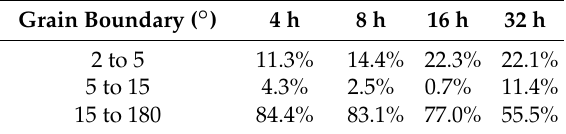
Table 4. Grain boundary distributions of the 4-h, 8-h, 16-h, and 32-h annealed